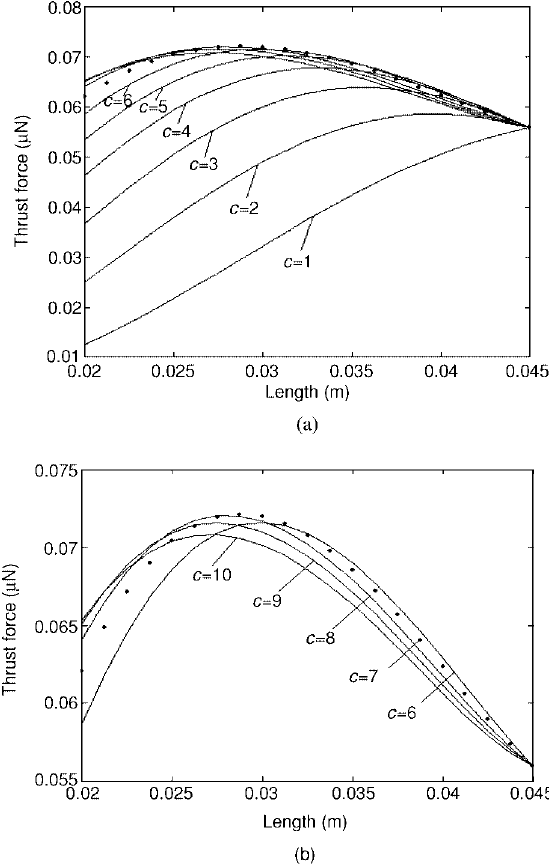
Figure 8 Propulsion diagram when b = 0.04: (a) c ∈ [1 , 6]; (b) c ∈ [6 , 10].